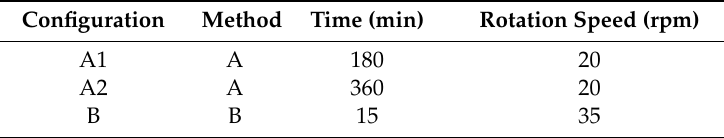
Table 3. Polish post-processing configuration parameters.